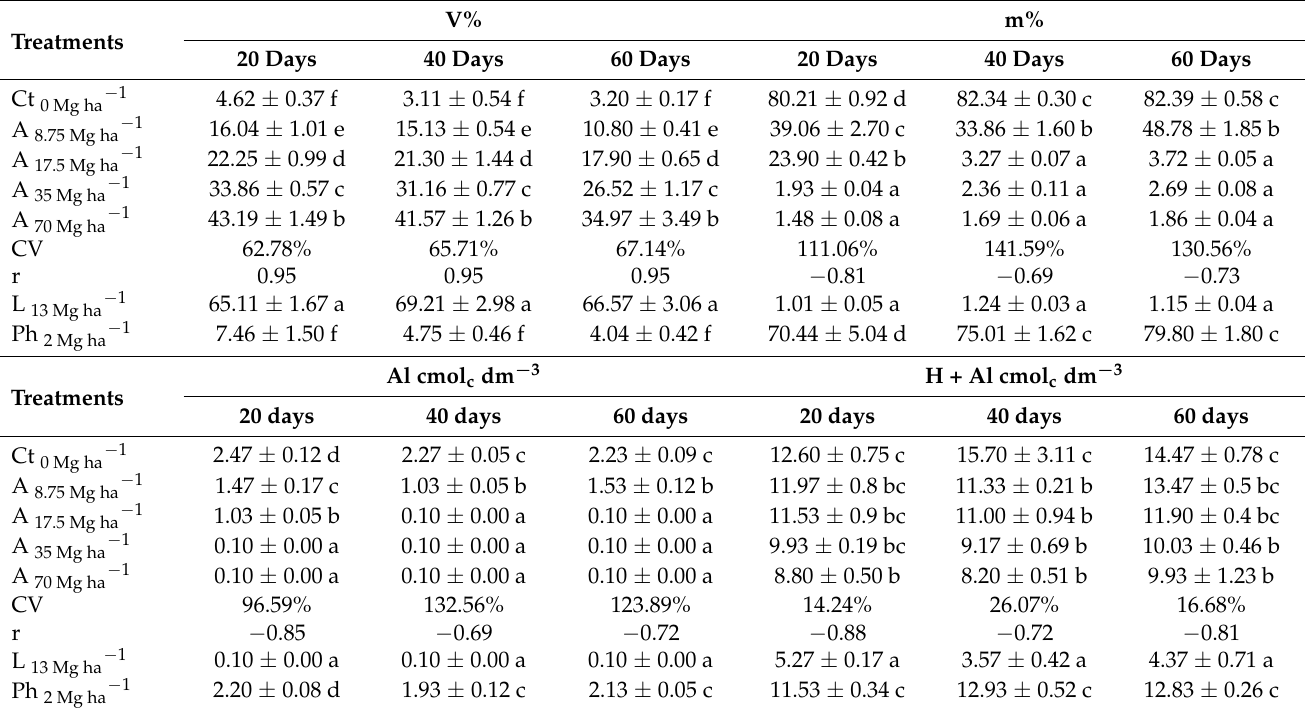
Table 5. Chemical attributes of the Yellow Latosol as a function of the application of ash from Amazonian biomasses, lime, and phosphate fertilizer. Mean values and standard deviations of base saturation (V) and Al (m), Al content, and potential acidity (H + Al) obtained after the three incubation